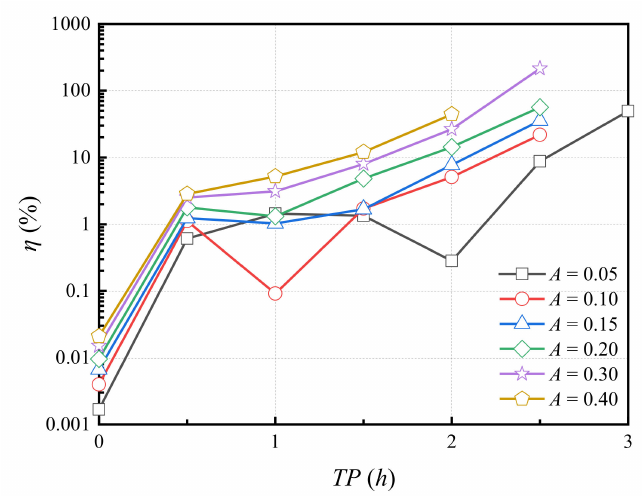
Figure 13. Cyclic load effect coefficient ( η ) with different working